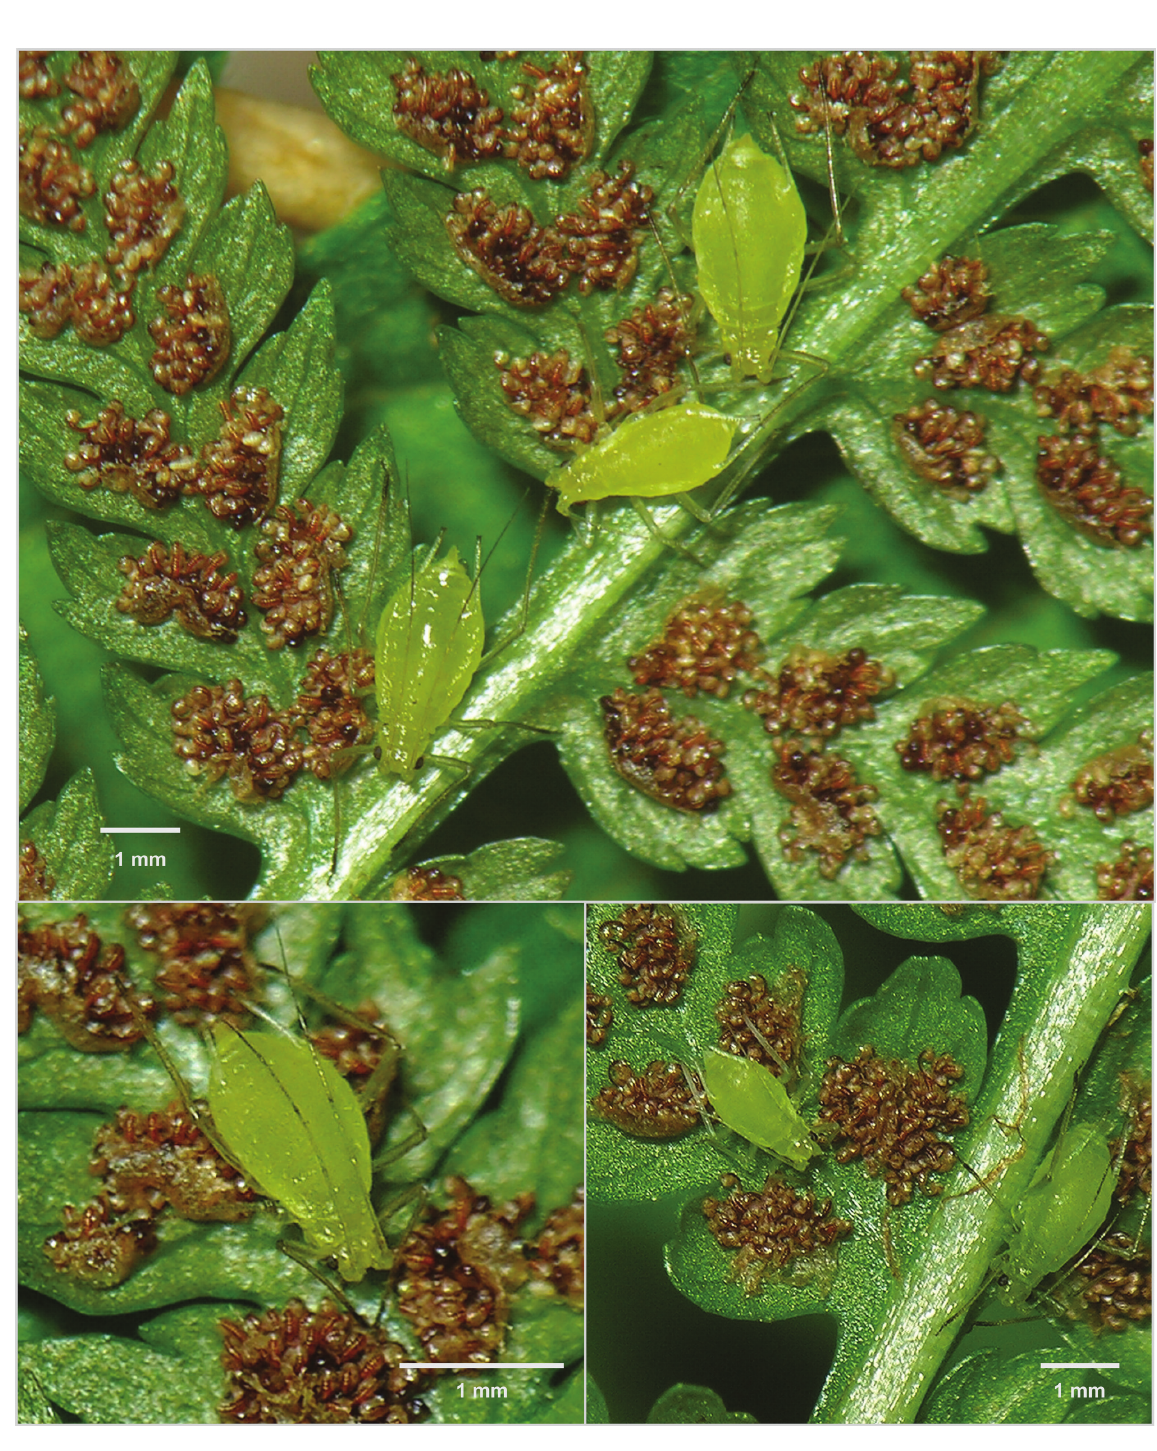
Fig. 35. Macrosiphum dryopteridis (holman, 1959). Apterae on Athyrium